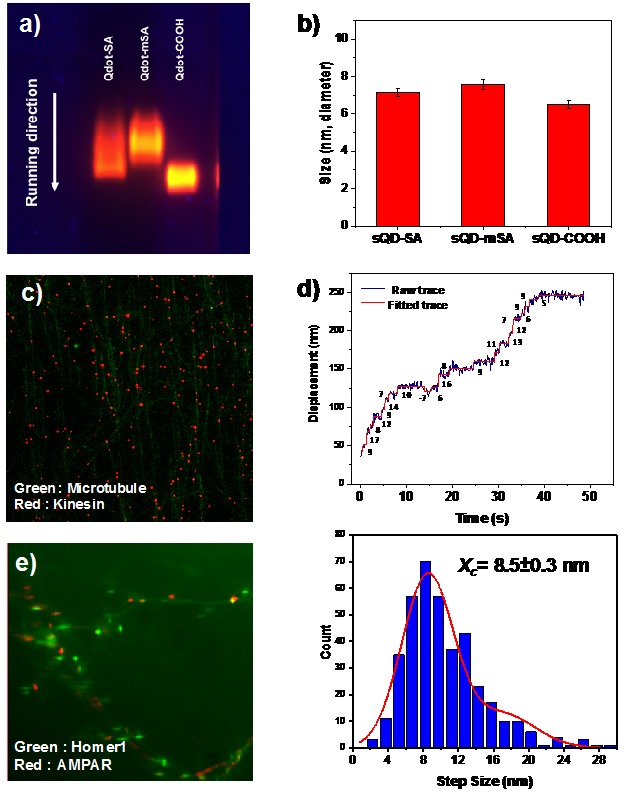
(a) Agarose gel image for SA-, mSA-, and carboxylated- small qdots and (b) histogram for their size.(c) Motor proteins (kinesin) labeled by mSA-small qdot (red dots) are on microtubules (green, HiLyte 488). (d) Kinesin walking trace and their step size which shows 8.5 nm. (e) mSA-small qdots label AMPA receptors on neurons (green fluorescence is Homer1). mSA-small qdots are specifically bound to AMPA receptors (red).